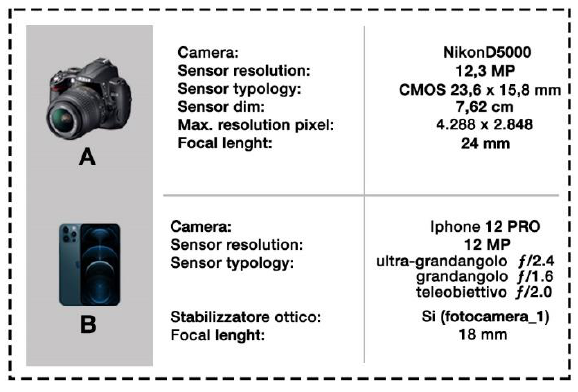
Figure 4. Main characteristics of the sensors used.